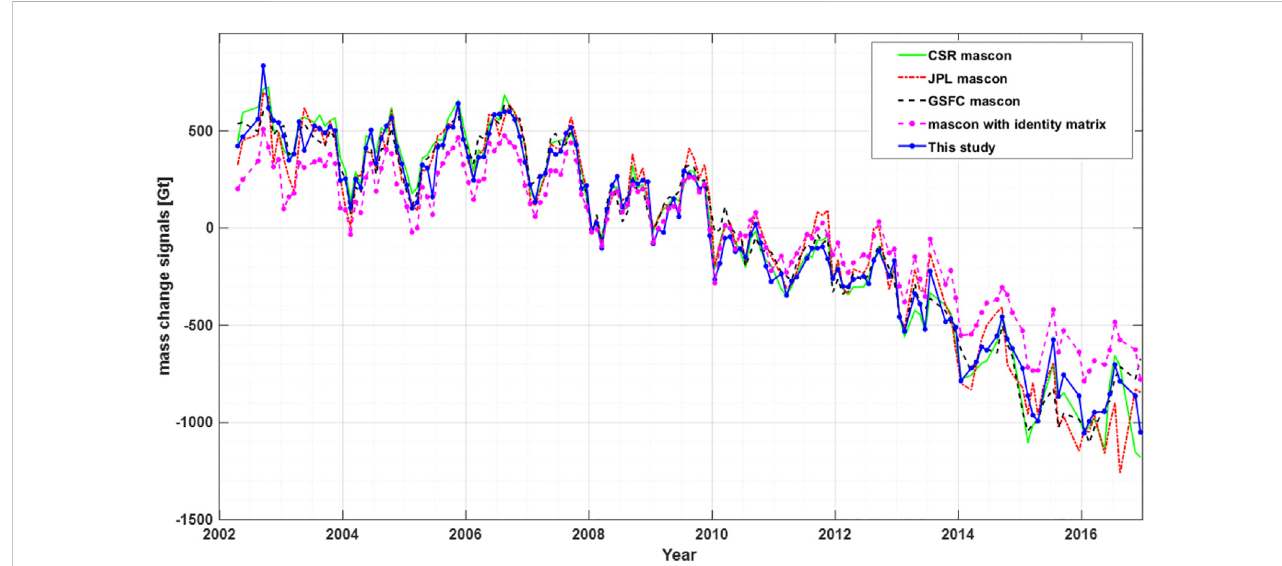
FIGURE 9 Time series of mass change signals over AIS from April 2002 to December 2016.